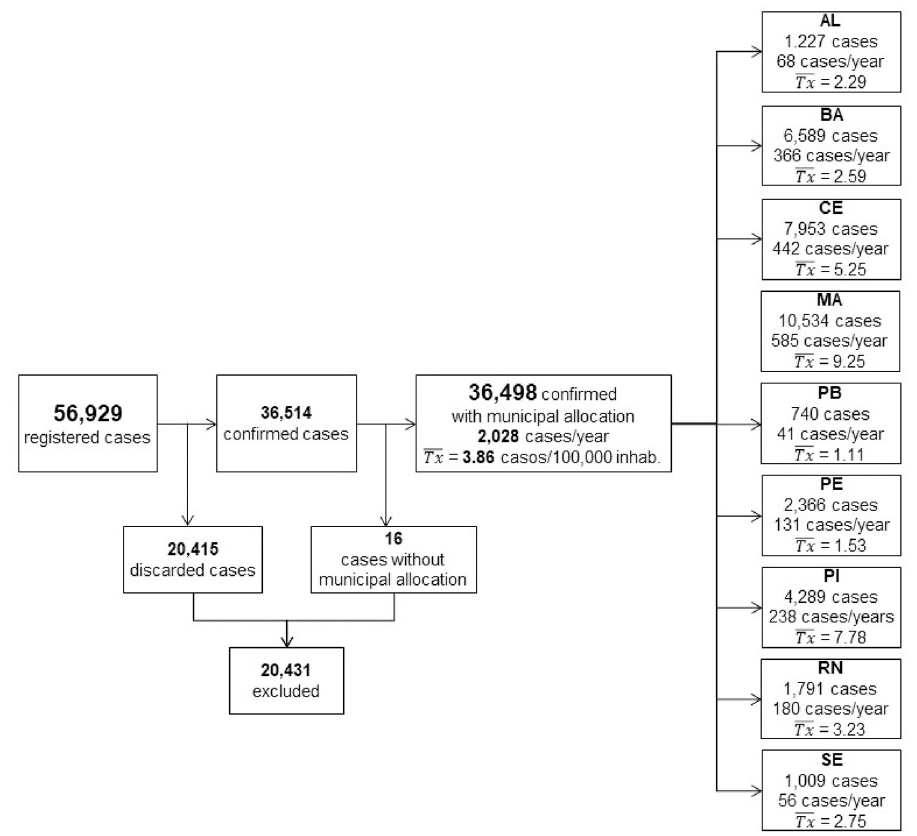
Fig 2. Flowchart of study population describing the number of cases, average frequencies, and annual prevalence rates per state. Tx : average prevalence (cases/100,000